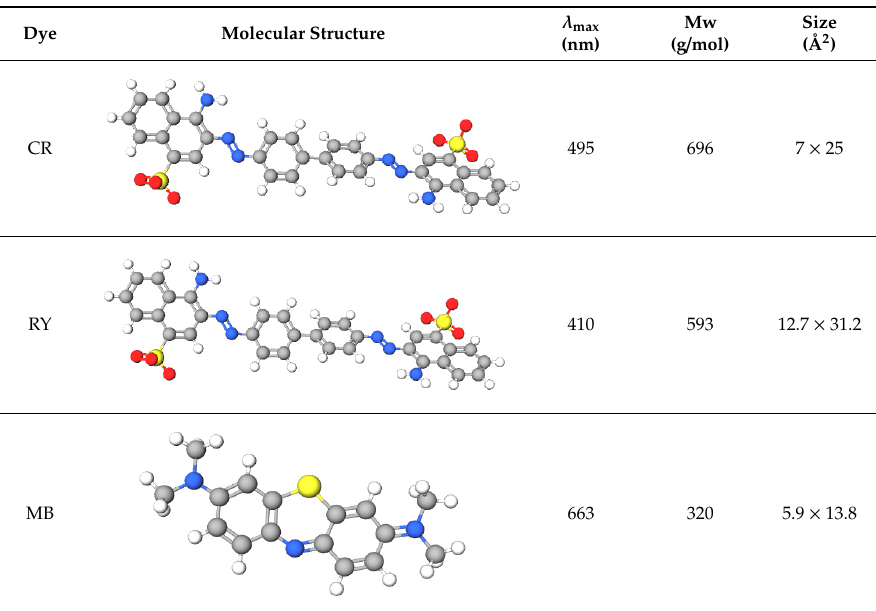
Table 6. Comparison of existing study with several earlier reports.